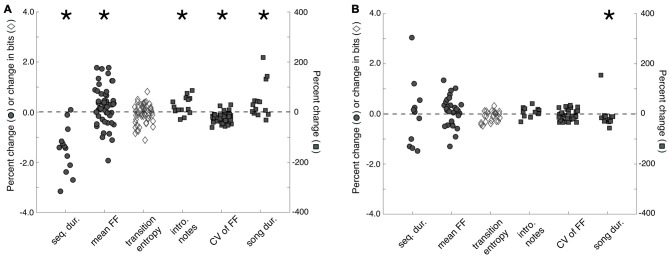
Changes to song structure as a function of social context and familiarity. (A) Sequence durations (“seq. dur.”) were significantly shorter, song durations (“song dur.”) were significantly longer, mean fundamental frequency (FF; “mean FF”) and the number of introductory notes (“intro. notes”) produced before song were significantly higher, and the variability of FF (“CV of FF”) was significantly lower for courtship songs than for non-courtship songs. To facilitate data visualization and feature comparisons, we present the percent changes (from non-courtship song to courtship song) for all features except transition entropy. For transition entropy, the change (in bits) from non-courtship song to courtship song is plotted. (B) To assess the effect of familiarity on song structure, we compared the structure of courtship songs produced during the first exposure to a female (i.e., when males are more likely to produce courtship song to a female) to the structure of courtship songs produced during subsequent exposures to a female (i.e., when males are less like to produce courtship song to a female). Only courtship song duration significantly decreased from the first exposure to subsequent exposures. Plotted is the change in transition entropy and the percent changes for all other features from courtship songs produced on a male’s first exposure to individual females to courtship songs produced on subsequent exposures to females. For both (A,B), filled circles and open diamonds scale to the left y-axis, whereas filled squares scale to the right y-axis. Introductory notes and sequence and song durations were analyzed per bird, whereas the mean and CV of FF and transition entropy were analyzed per syllable or sequence (see “Results” Section). “*” Indicates p < 0.05.